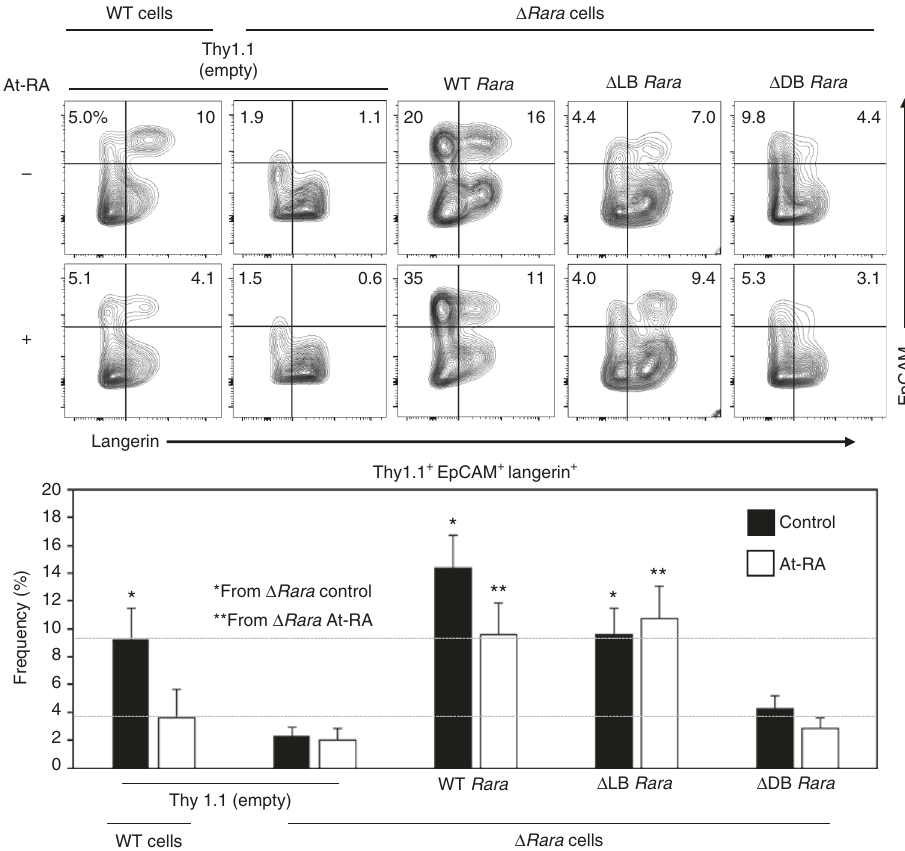
Fig. 6 The DNA binding, but not ligand binding, function of RAR α is required for BM-LC generation. Impact of RAR α variants on BM-derived LC differentiation in vitro. BM cells were transduced with retroviral vectors harboring WT and variant RAR α genes that lack ligand binding ( Δ LB) or DNA binding ( Δ DB) activity and differentiated with GM-CSF and TGF β 1 for 5 days in the presence of RA in medium containing charcoal-treated FBS. The data shown are for transduced Thy1.1 + CD11c + cells. Representative and combined data are shown. At-RA was used at 0.1 nM. Representative and combined data from 5 experiments are shown. * , **Signi fi cant differences by two-way ANOVA with Tukey adjustments ( p < 0.05). Error bars are de fi ned as